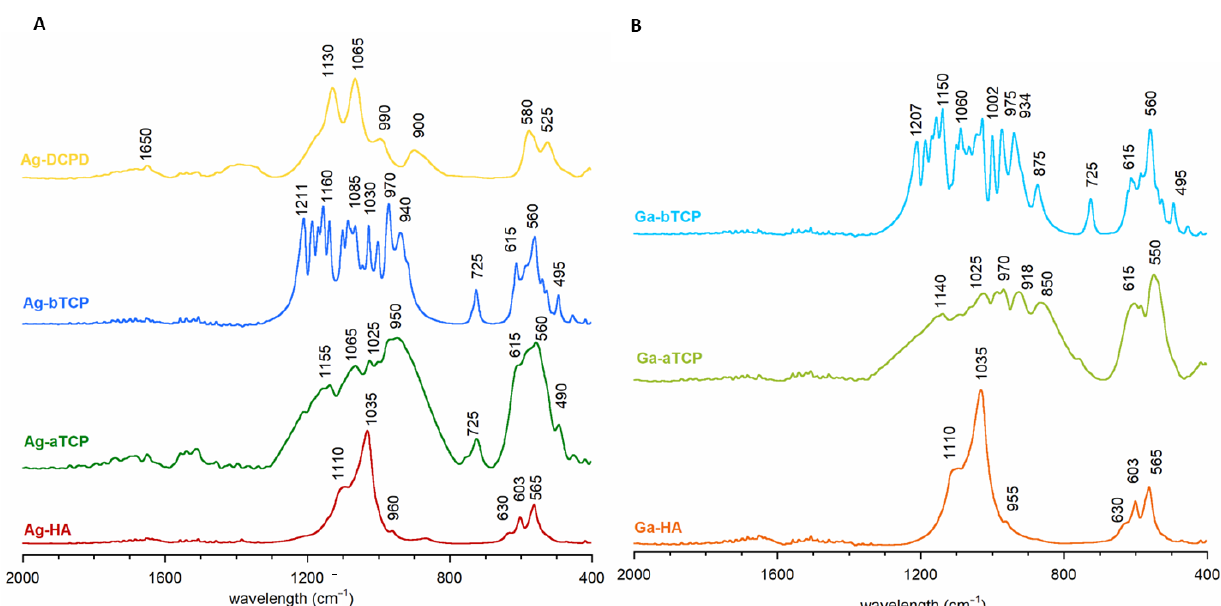
Figure 2. FT-IR spectra of the obtained calcium phosphates: ( A ) enriched with silver ion, ( B ) enriched with gallium ion.